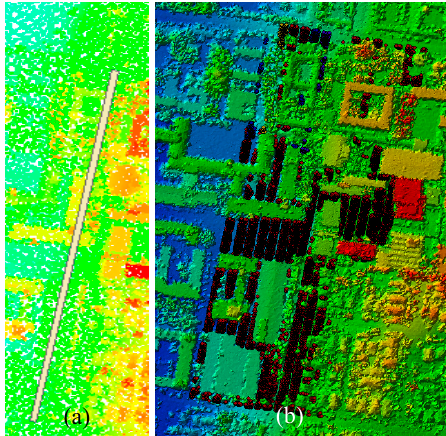
Figure 6. ( a ) Narrow and long window perpendicular to slope in slant area; ( b ) extracted ground points in slant area through parallel narrow long windows perpendicular to slope direction.